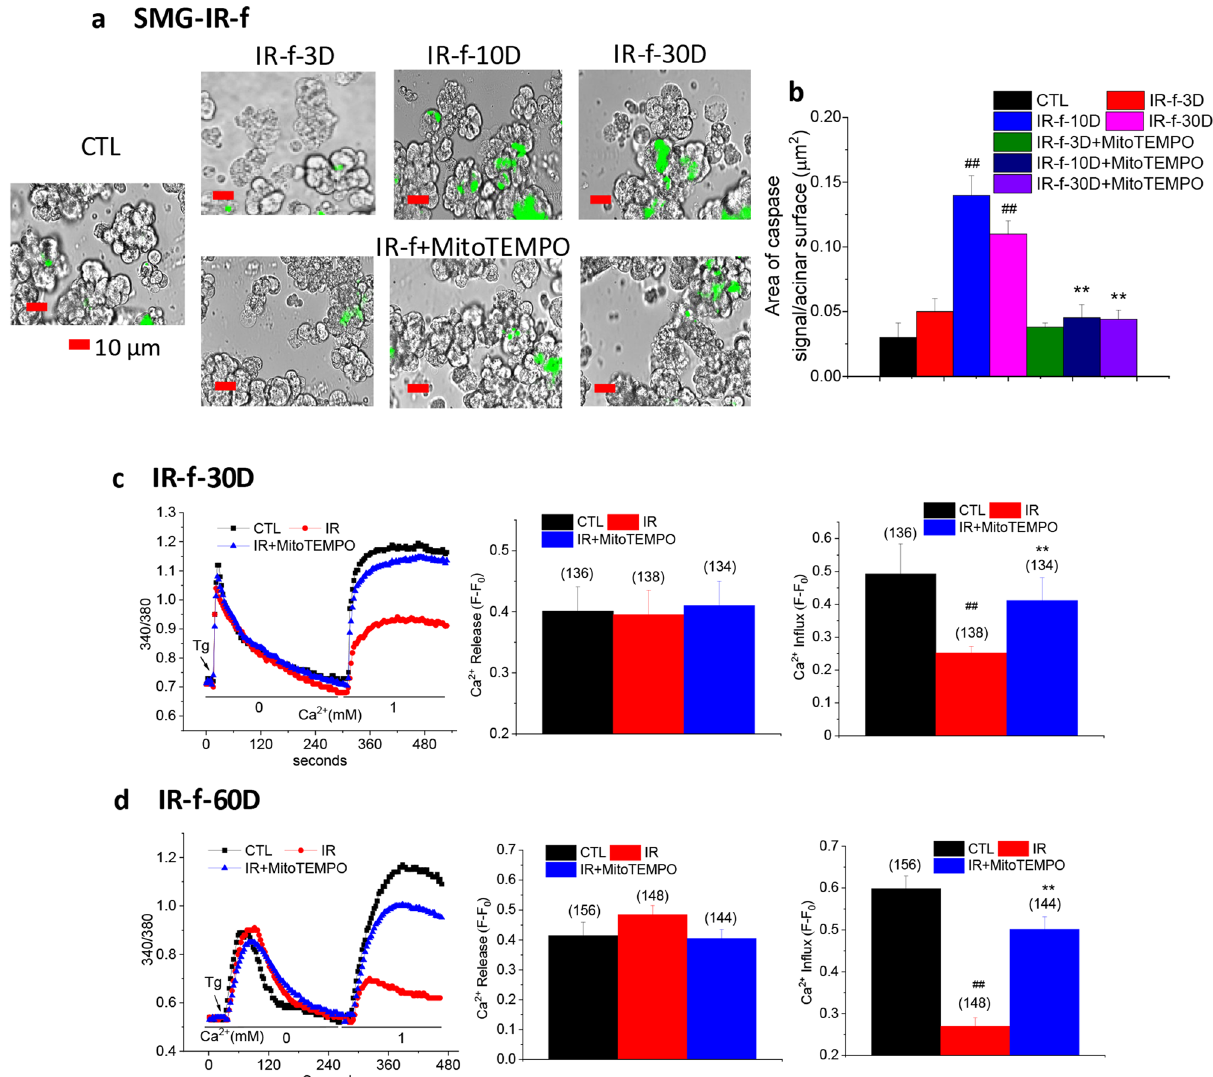
Figure 3. MitoTEMPO inhibited activation of capsase-3 and protected SOCE in mice receiving fractionated dose of IR. ( a ) Activated caspase-3 was detected in submandibular acinar cells using CellEvent Caspase3/7 Green Detection Reagent. SMG acinar cells were isolated from control mice (CTL) and those that received fractionated IR (IR-f) or IR + MitoTEMPO Cells were isolated 3, 10 and 30 days after IR. Representative data from at least 3 separate experiments are shown. Scale bar = 10 µm. ( b ) Bar graphs showing area of caspase-3 signal/total surface acinar area for each group of cells. χ 2 test was used to determine the statistical significance. Values marked with **p < 0.01, indicate significant difference as compared with the same time point in the IR group, but not from CTL. ## p < 0.01, indicates values that are significantly different from CTL. Unmarked values are not different from each other. Data were obtained from > 200 cells per group from at least 3 independent experiments. ( c , d ) Fura-2 fluorescence was monitored in salivary gland acinar cells isolated from control mice (CTL), irradiated without MitoTEMPO (IR) and with MitoTEMPO treatment (IR + MitoTEMPO), 30 and 60 days after IR. Representative traces, left panels in c and d, show Tg-stimulated Ca 2+ release (increase in 340/380 fluorescence ratio in Ca 2+ -free medium) and Ca 2+ influx components (increase in 340/380 fluorescence ratio in when Ca 2+ is added back to the medium). Average data are presented in the middle (peak change during release) and right panels (peak change during influx) in ( c , d ). The data were obtained from at least three different experiments (each with individual mice) with 134–156 cells for each group. Data shows mean ± SEM and statistical evaluation was done using unpaired t test. Unmarked values (middle panel) are not different from each other. Values marked ## in bar graphs indicates significant difference as compared with CTL (p < 0.01); ** indicates values that are significantly different as compared with control and IR groups (p <